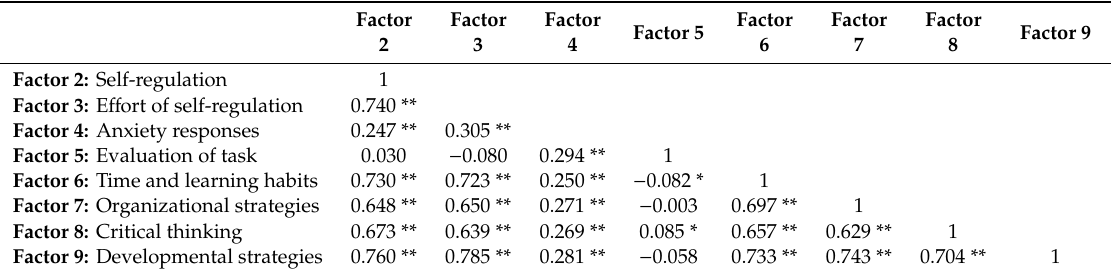
Table 5. Correlation of factors.